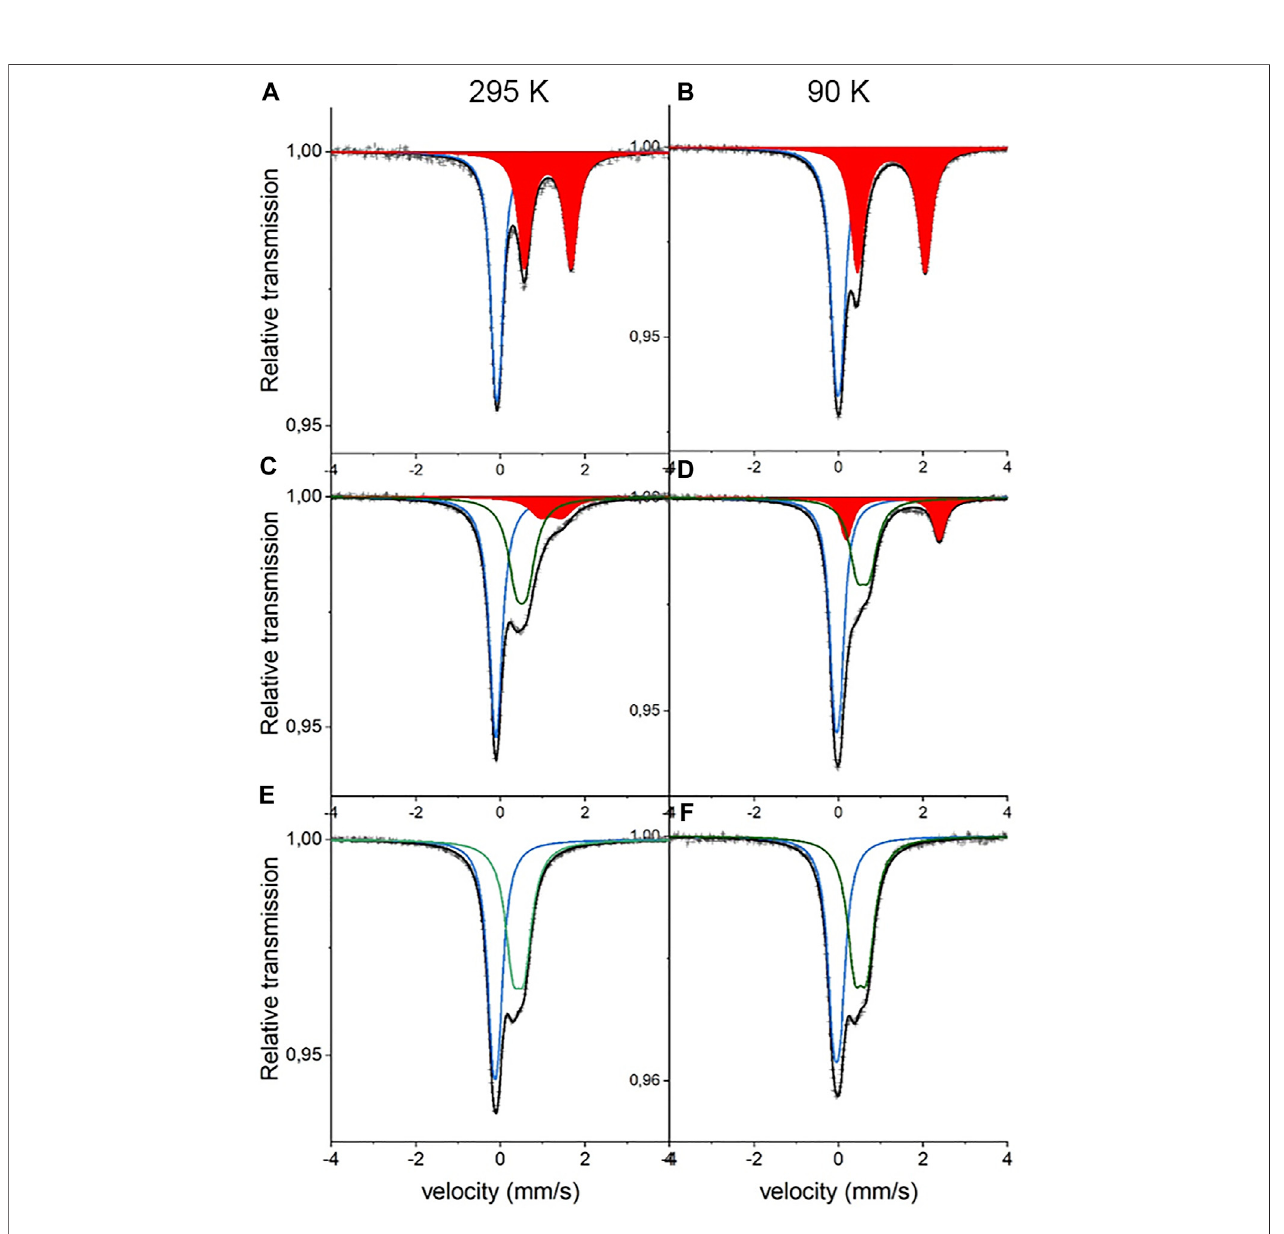
FIGURE 1 | Mössbauer spectra of Na x Fe [Fe(CN) 6 ].nH 2 O at 295 K (left panel) and 90 K (right panel). (A,B) are x = 1.8 (C,D) are x = 1.0, and (E,F) are x = 0.5. Blue sub-spectra represent low-spin Fe C2+ , red sub-spectra represent high-spin Fe N2+ , and green sub-spectra represent high-spin Fe N3+ .